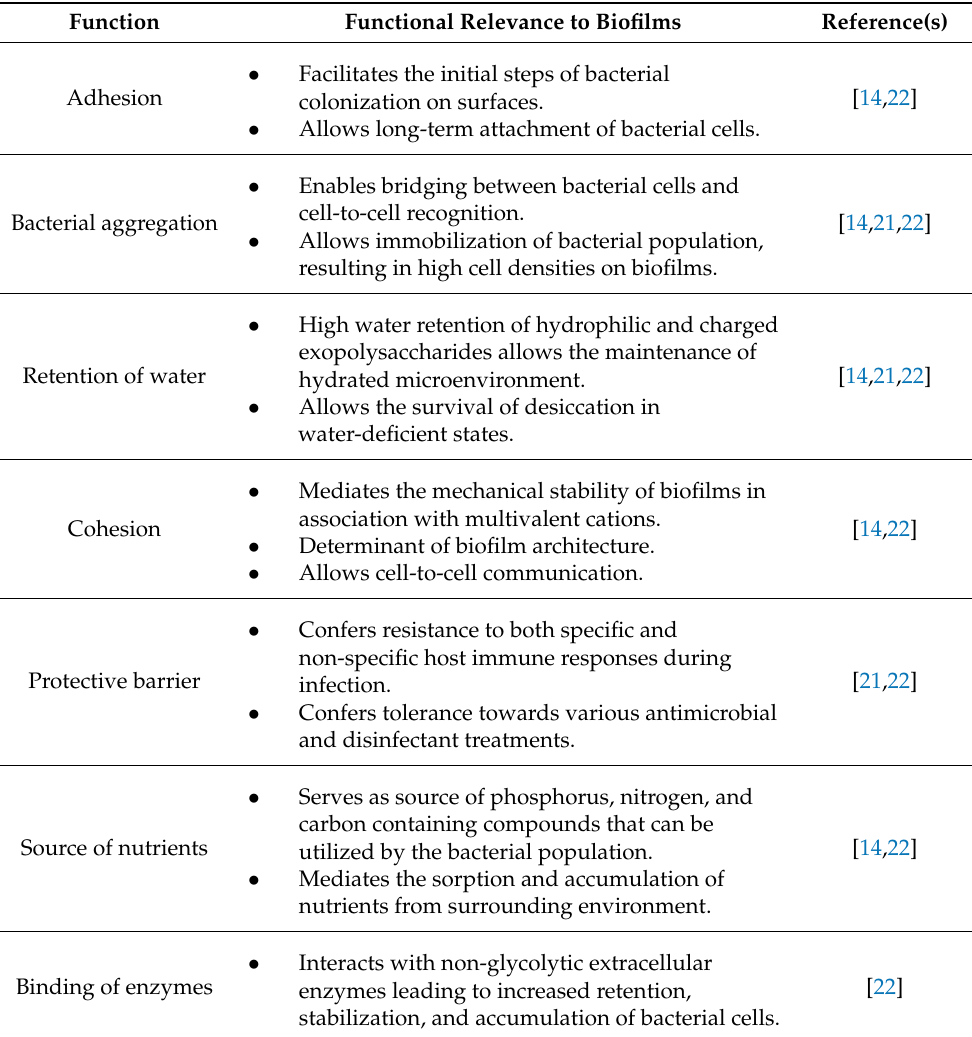
Table 2. Summary of the functions of exopolysaccharides and their relevance to